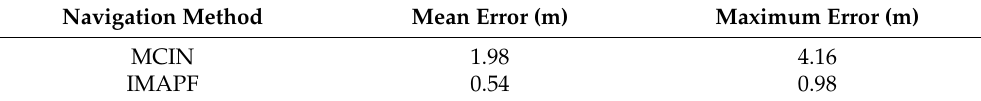
Table 6. Error comparison under the condition that the initial position and heading are